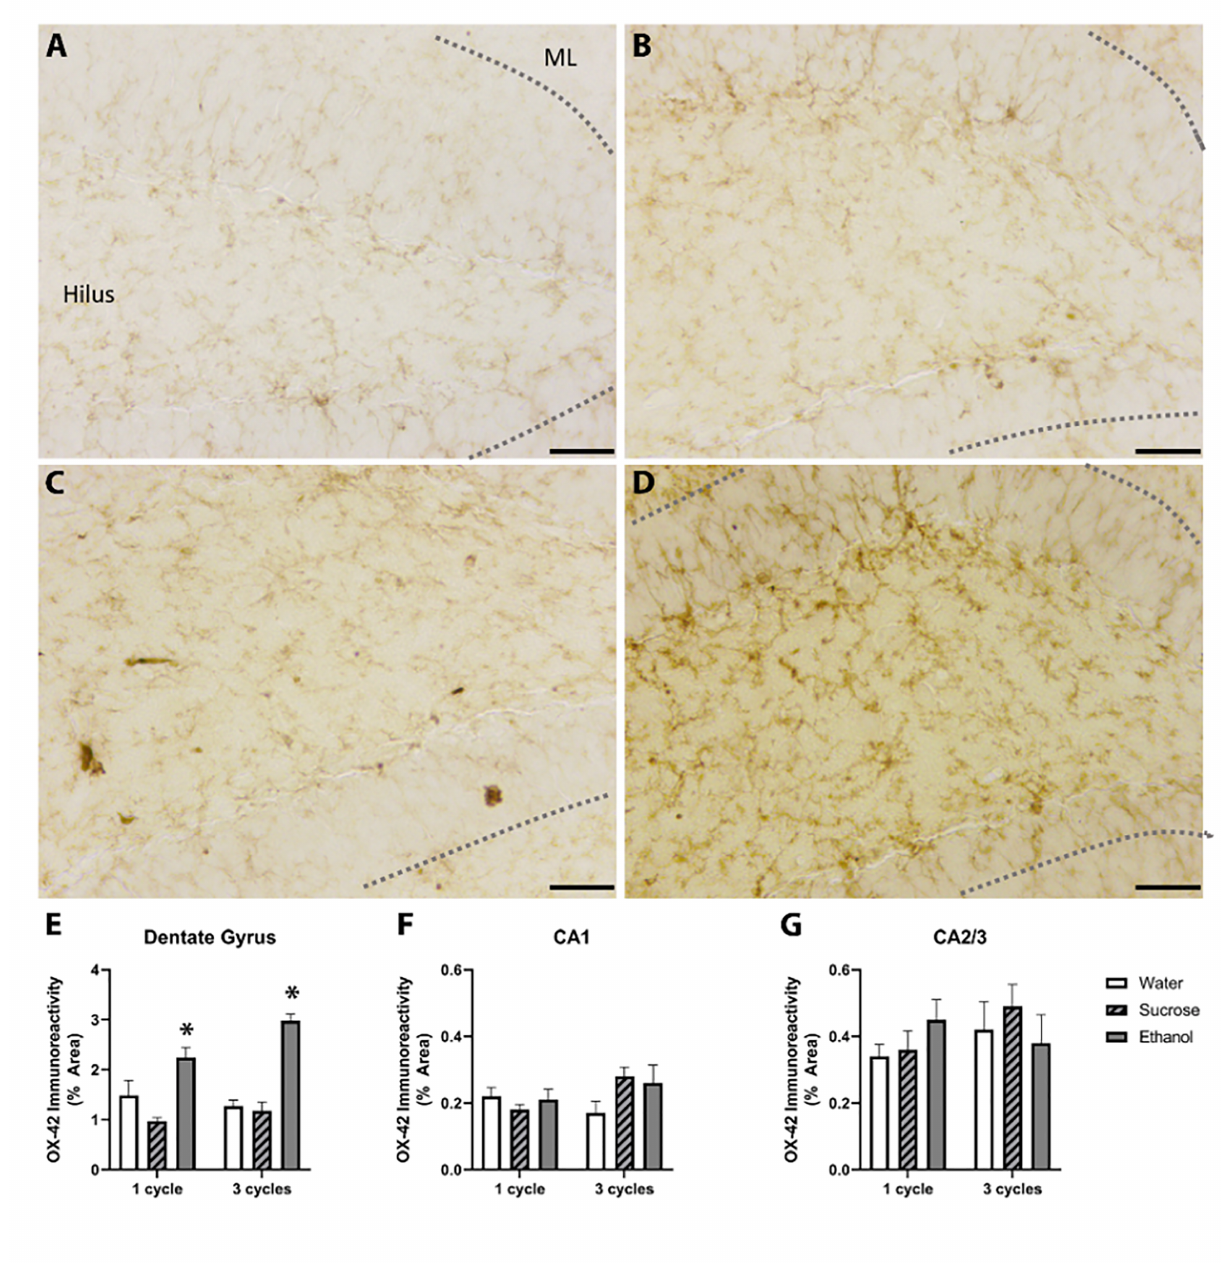
Fig. 4. Binge-like consumption increases microglial expression of the immunologic CR3. Ox-42 immunoreactivity was upregulated in the dentate gyrus. Representative photomicrographs of the dentate gyrus of mice given access to 3 cycles of water (A), 3 cycles of sucrose (B), 1 cycle of EtOH (C), or 3 cycles of EtOH (D). The dashed grey lines outline the edges of the granular cell layer of the DG. Quantification of the immunoreactivity (IR) indicated that after 1 and 3 cycles of EtOH, there were increases in the IR in the DG (E) but not the cornu amonis regions (F, G). * p > 0.05 compared to water; Scale bars in representative photomicrographs = 75 µ m. ML, molecular